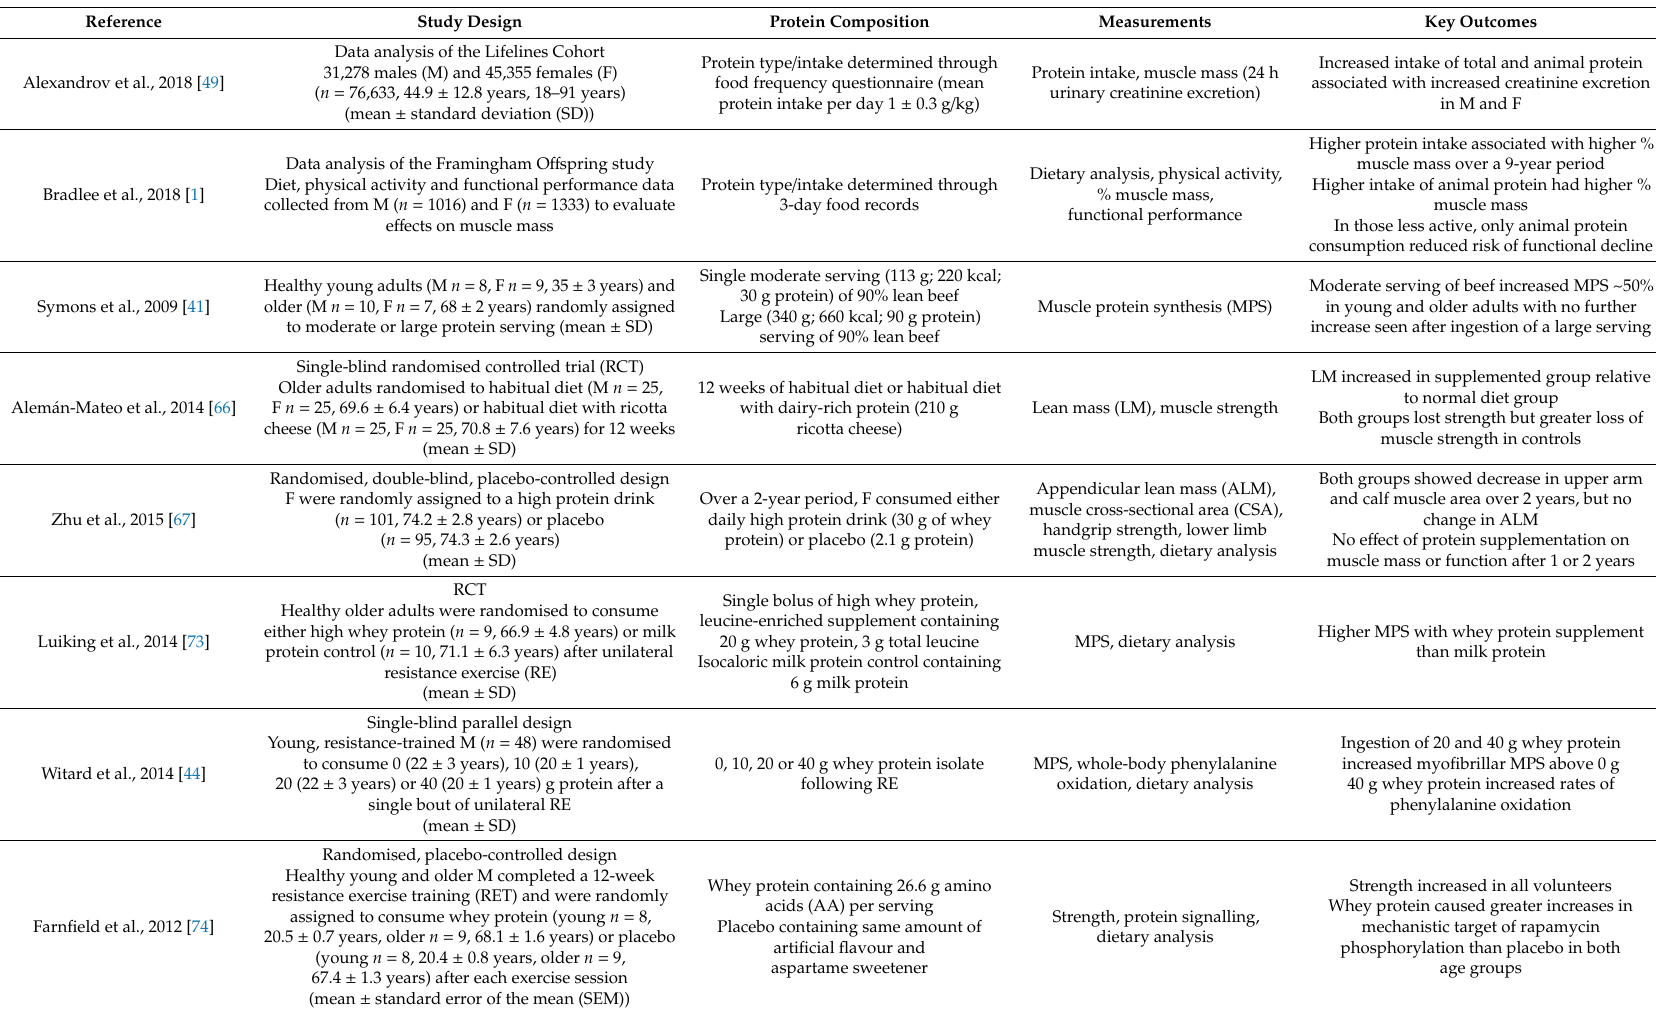
Table 1. Animal-derived proteins: e ff ects on muscle in relation to age, exercise, energy restriction and